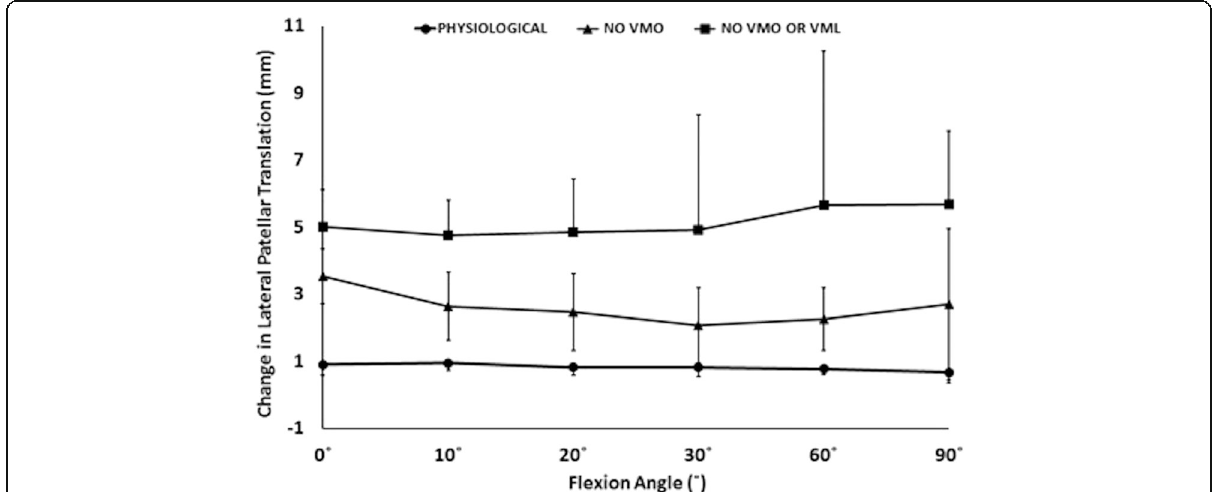
Fig. 7 Change of patellar lateral translation in response to a 10 N lateral displacing force, showing increased effect after relaxation of the VMM